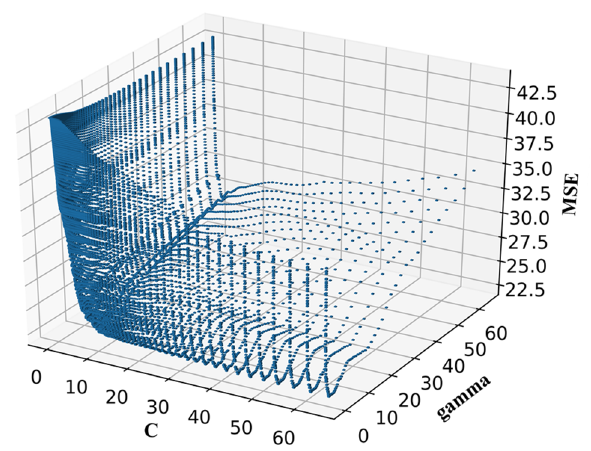
Figure 12. The MSE of the support vector regression (SVR)model with different C and gamma . Note: The range of parameter C is from 2 M to 2 N and M is −6, N is 6 and the step length between M and N is 0.1; The range of parameter gamma is from 2 M to 2 N and M is −6, N is 6 and the step length between M and N is 0.1;.